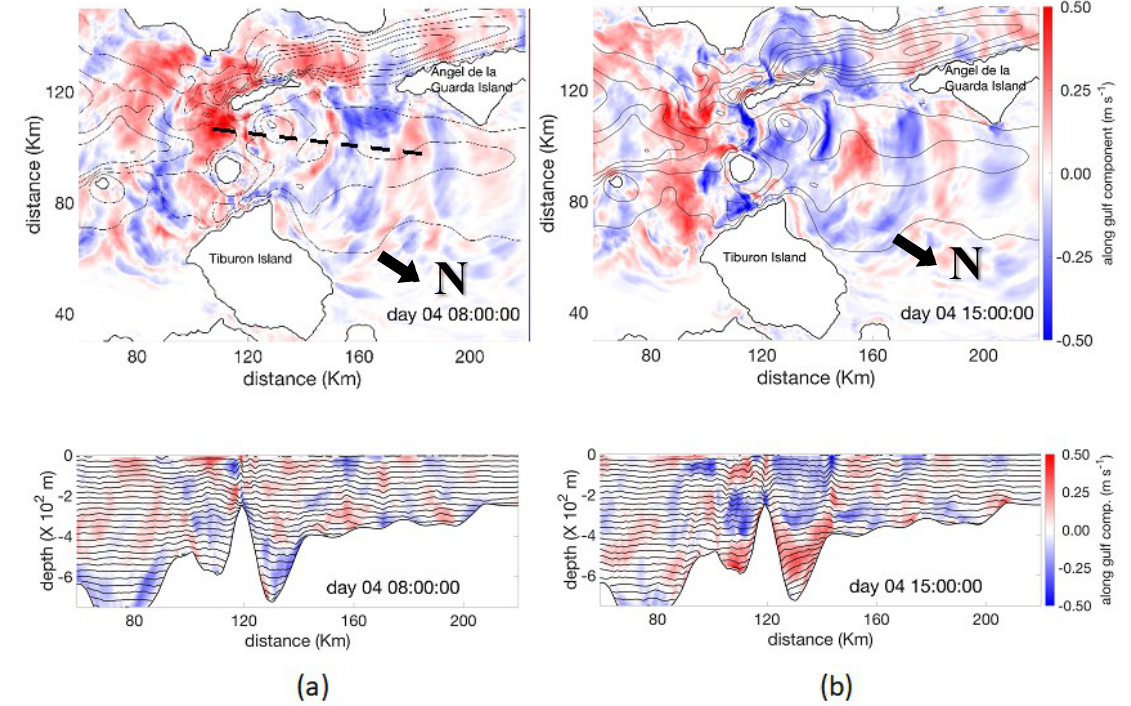
Figure 3. Maps of the surface (upper) and vertical (bottom) profiles of the along-gulf velocity component at two periods of model simulation ( a ) during the maximum entrance of tidal velocity (see red tones between the Islands) and ( b ) during the internal wave front propagation towards the northern gulf (see black arrow on high blue tones).